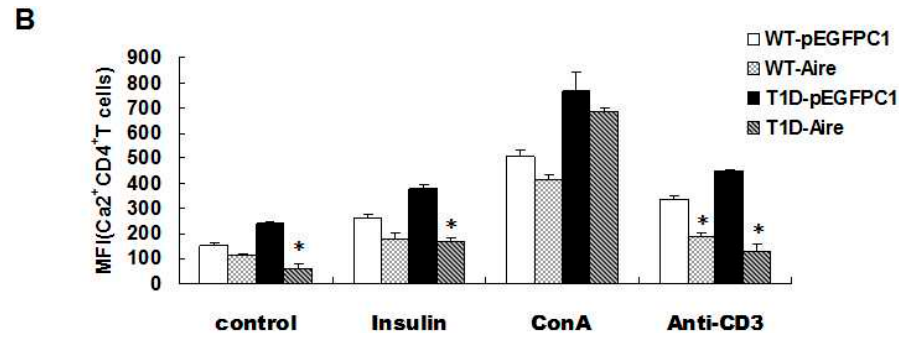
Figure 3. Aire cells affected TCR signaling in CD4 + T cells among the splenocytes from STZ-T1D mice. The splenocytes from STZ-induced T1D mice and WT mice co-cultured with Aire or control cells in the presence of insulin, ConA or an anti-CD3 antibody for 48 h. ( A ) The p-ERK expression levels; and ( B ) the concentration of Ca 2+ in CD4 + T cells were examined by FACS. The results are presented as the average percentage ± SD ( n = 5); each experiment was repeated at least three times. * p < 0.05, Aire vs. pEGFPC1.